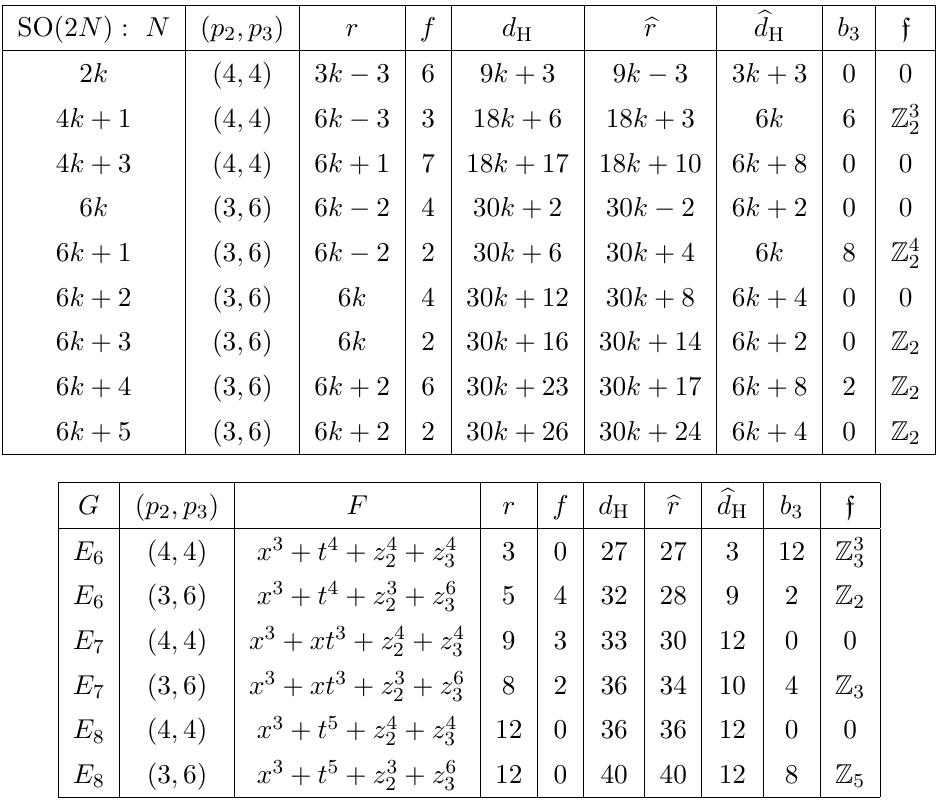
Table 15 . Trinion models of the type described in section 7.2.1. with b 2 = b 3 = h ∨ .